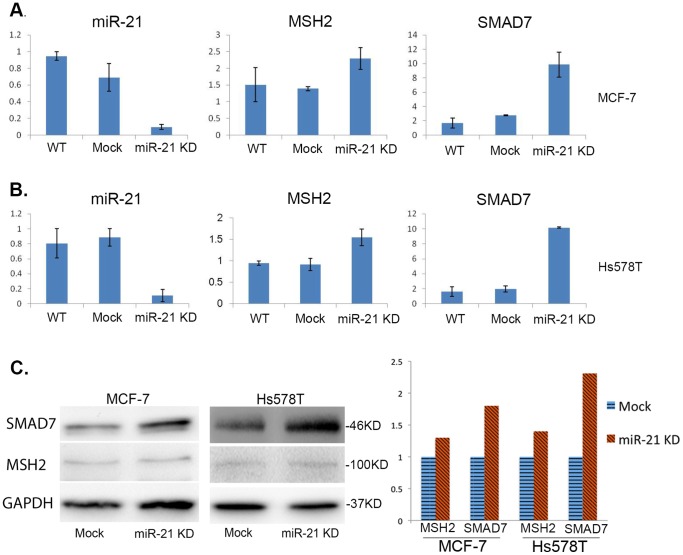
Knockdown of miR-21 restores the expression of SMAD7 and MSH2 in MCF-7 and Hs578T breast cancer cell lines.MCF-7 and Hs578T cells were transfected with miR-21 inhibitor and a negative mock control using the Lipofectamine 2000 kit (Invitrogen). After 48 hrs, miR-21 expression level was knocked down by ∼10 fold as compared to the mock controls in both MCF-7 (Fig. 6A) and Hs578T (Fig. 6B) cell lines using the Invitrogen SYBR green qRT-PCR kit. Untransfected cells were also included in the analysis (WT). With down-regulated miR-21 in both MCF-7 and Hs578T cells, MSH2 and SMAD7 mRNA expression was up-regulated by ∼1.67 and ∼3.6 fold, respectively (Fig. 6A and 6B), while the protein level was increased by ∼35–43% for MSH2 and ∼80–133% for SMAD7 (Fig. 6C).